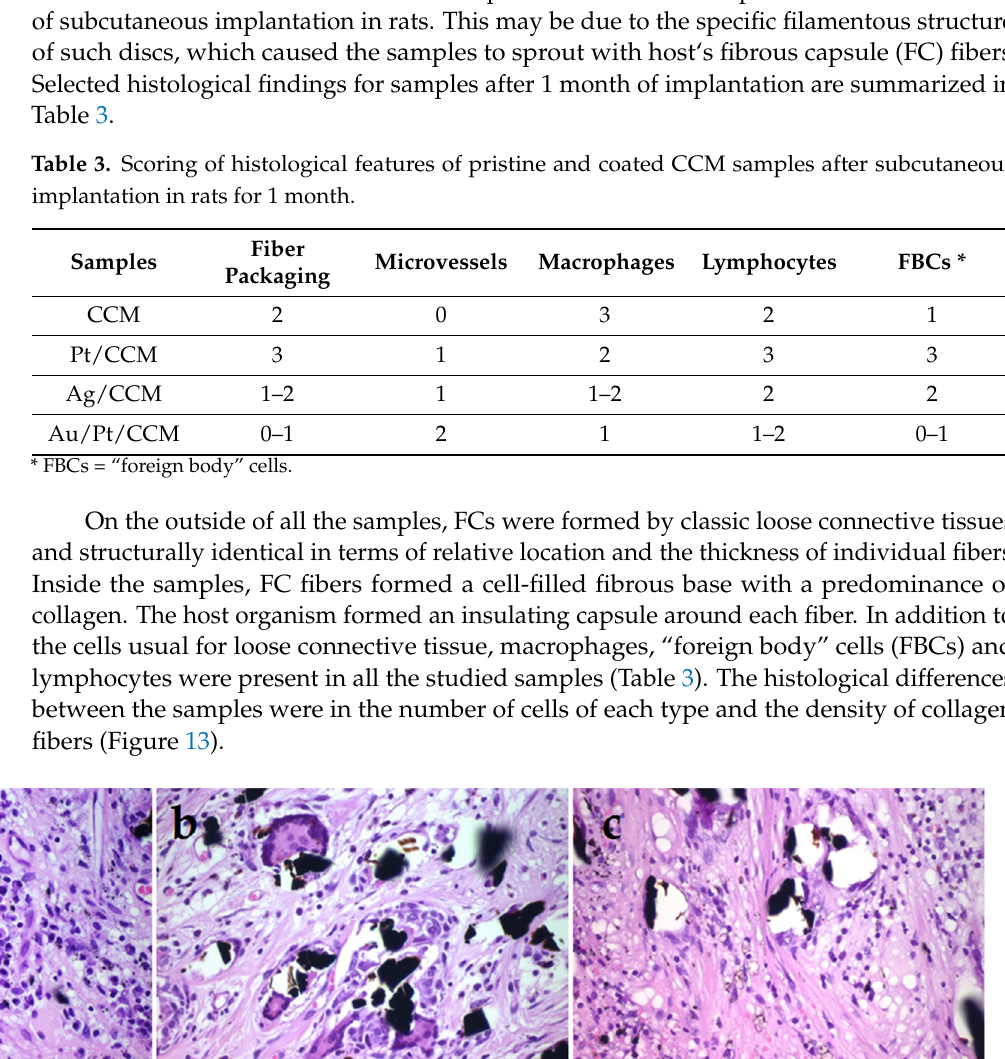
Table 3. Scoring of histological features of pristine and coated CCM samples after subcutaneous implantation in rats for 1 month.